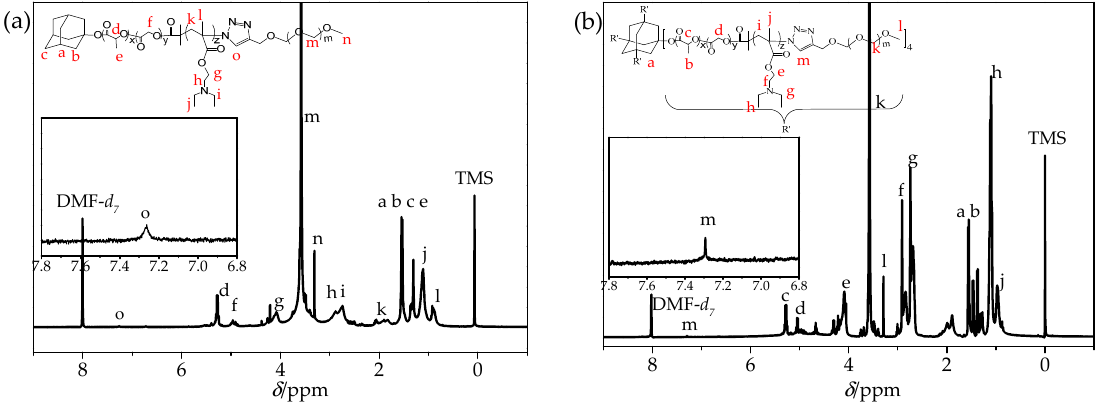
Figure 2. 1 H NMR spectra of L-PLGA-D-P ( a ) and S-PLGA-D-P ( b ).